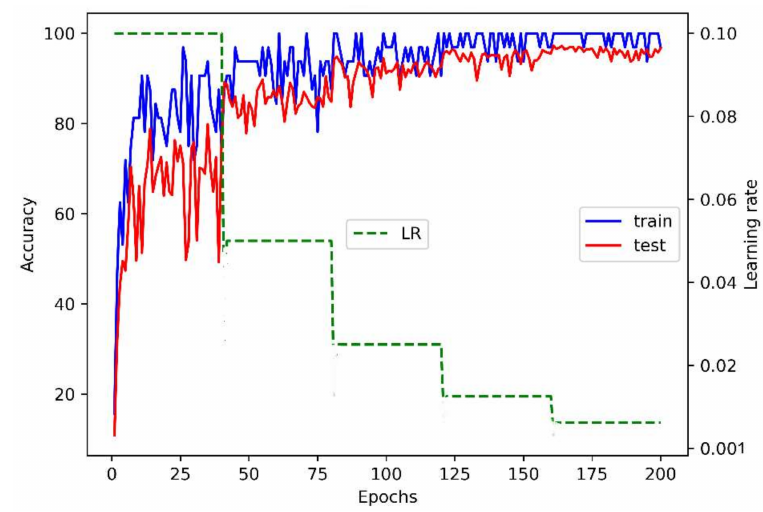
Figure 7. The behavior of the optimized architecture on the KSU-SSL dataset.